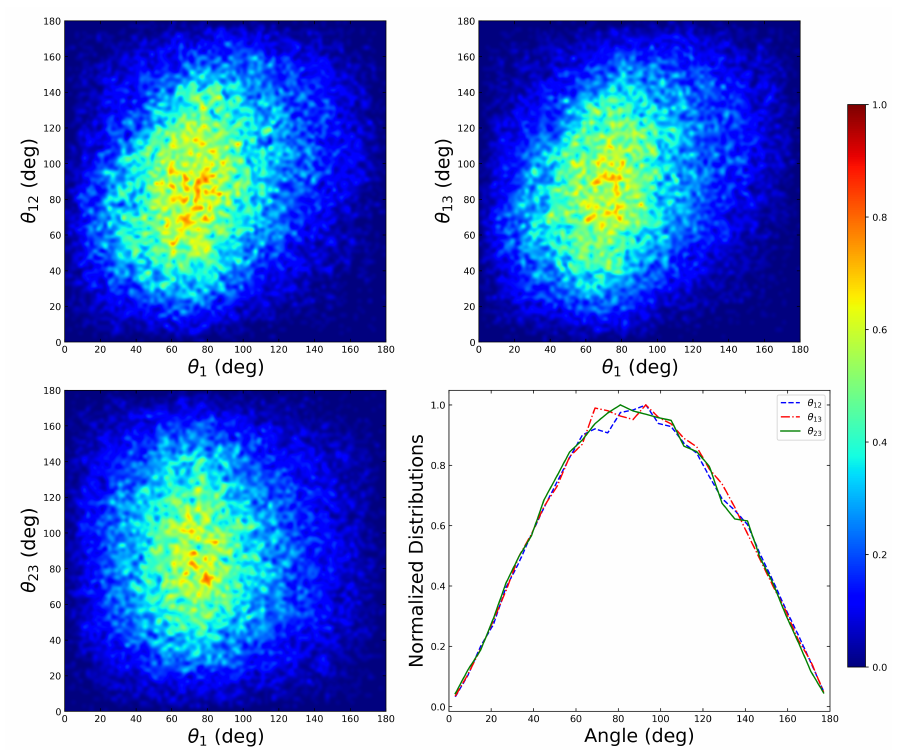
Figure 6. Normalized contour plots θ 12 vs. θ 1 , θ 13 vs. θ 1 and θ 23 vs. θ 2 together with a histogram of events for the interelectronic angles θ 12 , θ 13 and θ 23 for triple ionization.